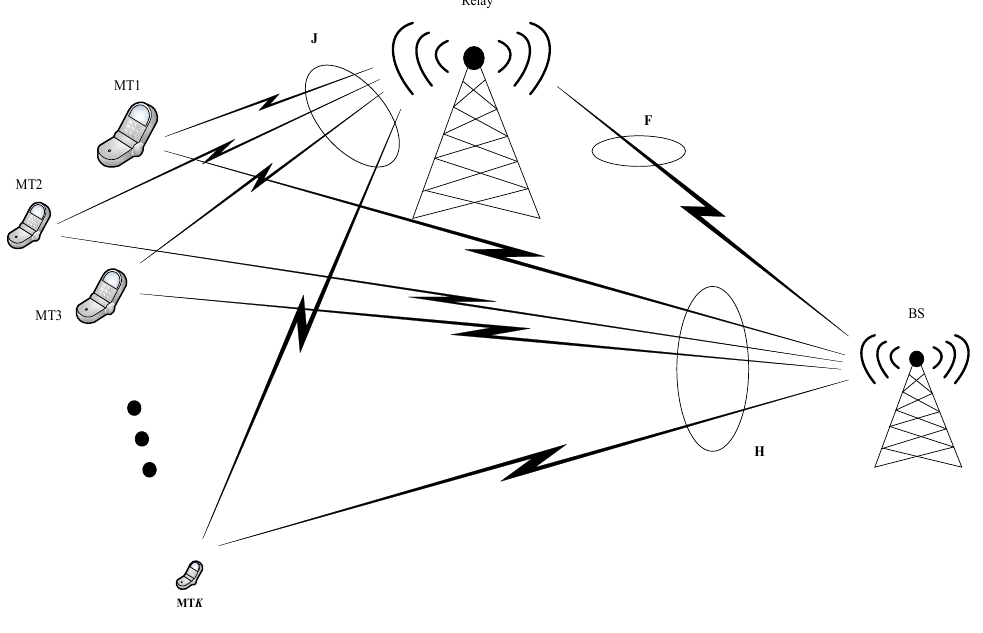
Figure 2. The architecture of the proposed system.